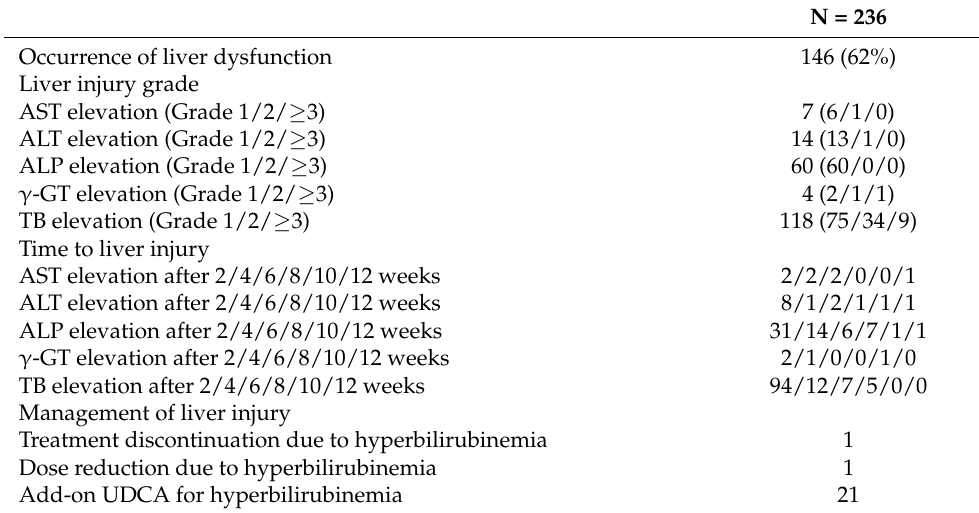
Table 2. Incidence, grade, time to onset, and management of glecaprevir/pibrentasvir-induced liver injury.